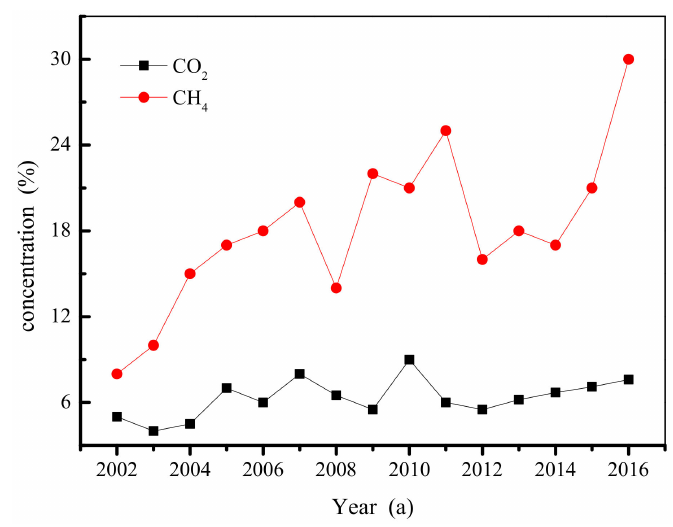
Figure 6. Yearly changes in the absolute gas emission of over mine. The 20180 mining face is located in the fourth stage of the Central Group of the No. 10 Mine. The mining face is located in the east of the mining area, three downhills, west to the east of the No. 25 exploration line, 200 m east, and the south is the 20,160 goaf, the north has not yet been mined; a diagram of the relationship between coal gas content and depth is shown in Figure 7. It can be seen from Figure 7 that the test data points and the fitting relationship curve in the figure have a linear relationship; that is, with the increase in the coal seam burial depth, the gas content increases linearly, which greatly increases the gas drainage